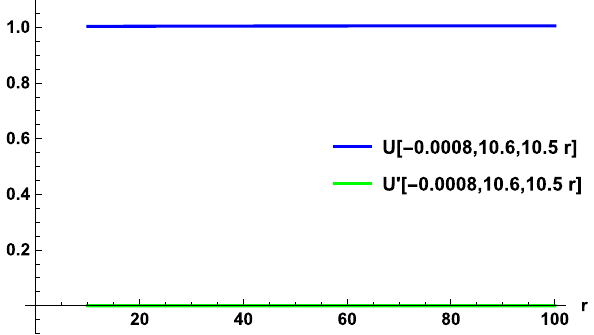
Fig. 8 (Left) Constant hypergeometric function U [− 0 . 0008 , 10 . 6 , 10 . 5 r ] and its derivative U (cid:15) [− 0 . 0008 , 10 . 6 , 10 . 5 r ] (cid:17) 0 for (left) Fig. 7